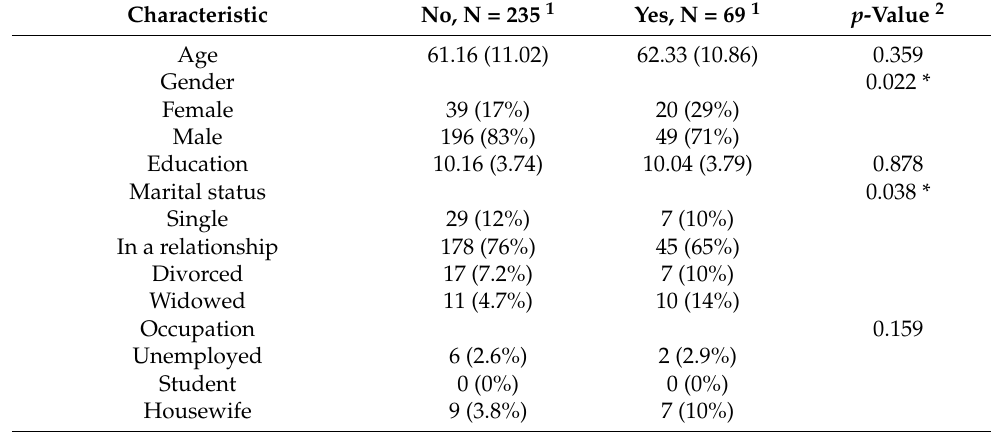
Table 2. Sample baseline characteristics according to the occurrence of MDE during the